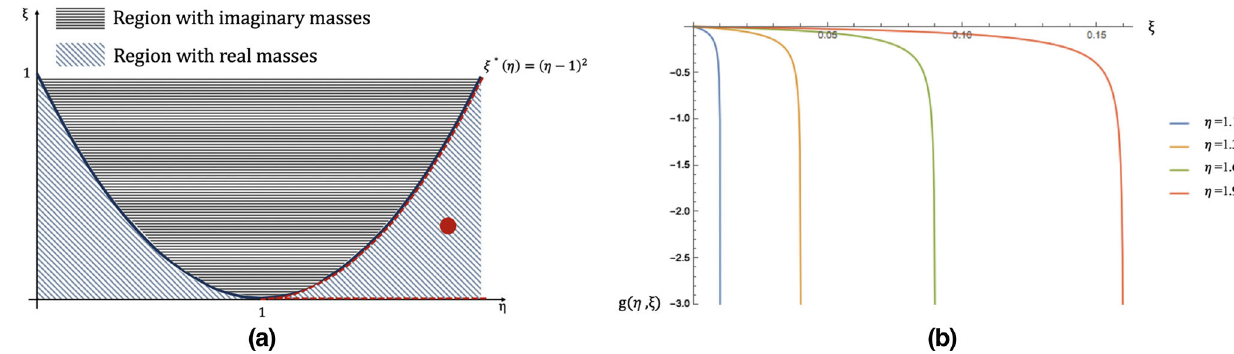
Fig. 4 a Models with the structure f ( R , φ) + ω(φ)φ ; α φ ; α can be represented in η ξ − plan as the generic point (red): { (η,ξ) | η > 1 , 0 < ξ < ξ ∗ (η) } ; b graph of the function g (η,ξ) with η > 1